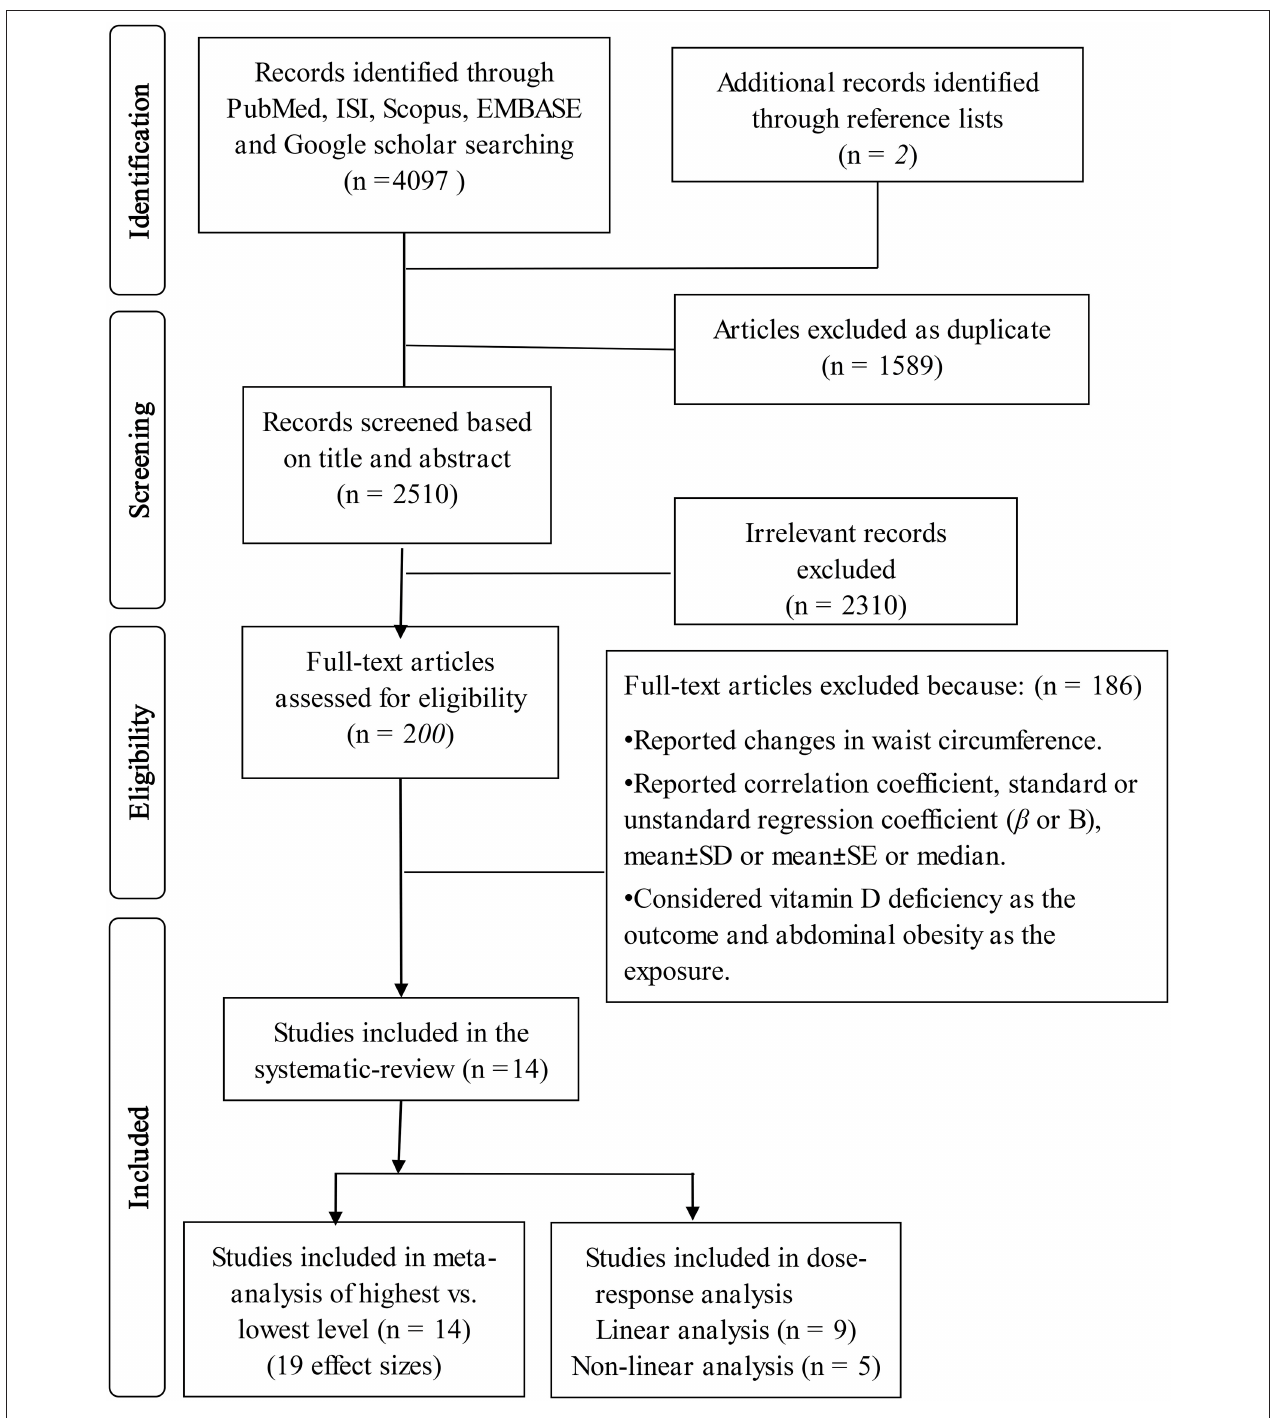
FIGURE 1 | Flow diagram of the search strategy and study